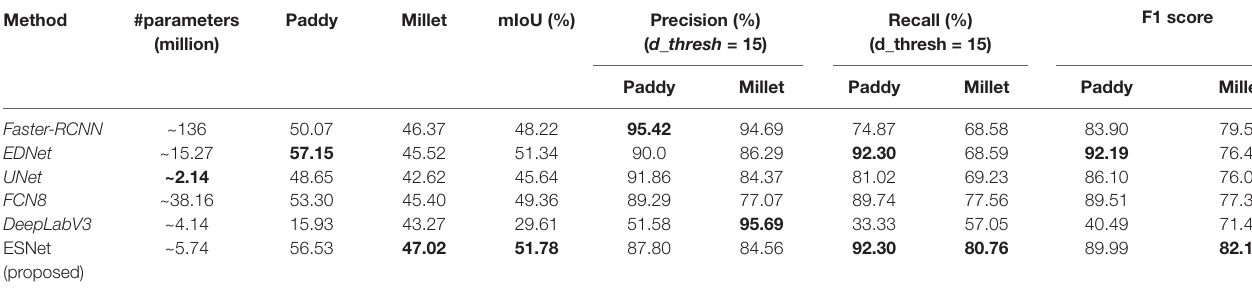
TABLE 3 | Comparison of different variants of Faster-RCNN and the proposed method on the paddy–millet